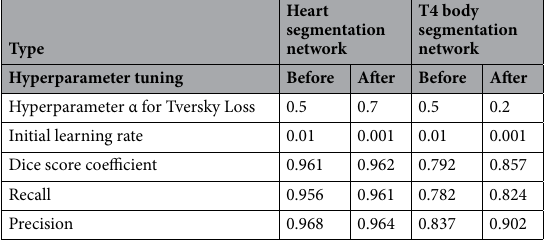
Table 4. Key performance indices of segmentation networks.